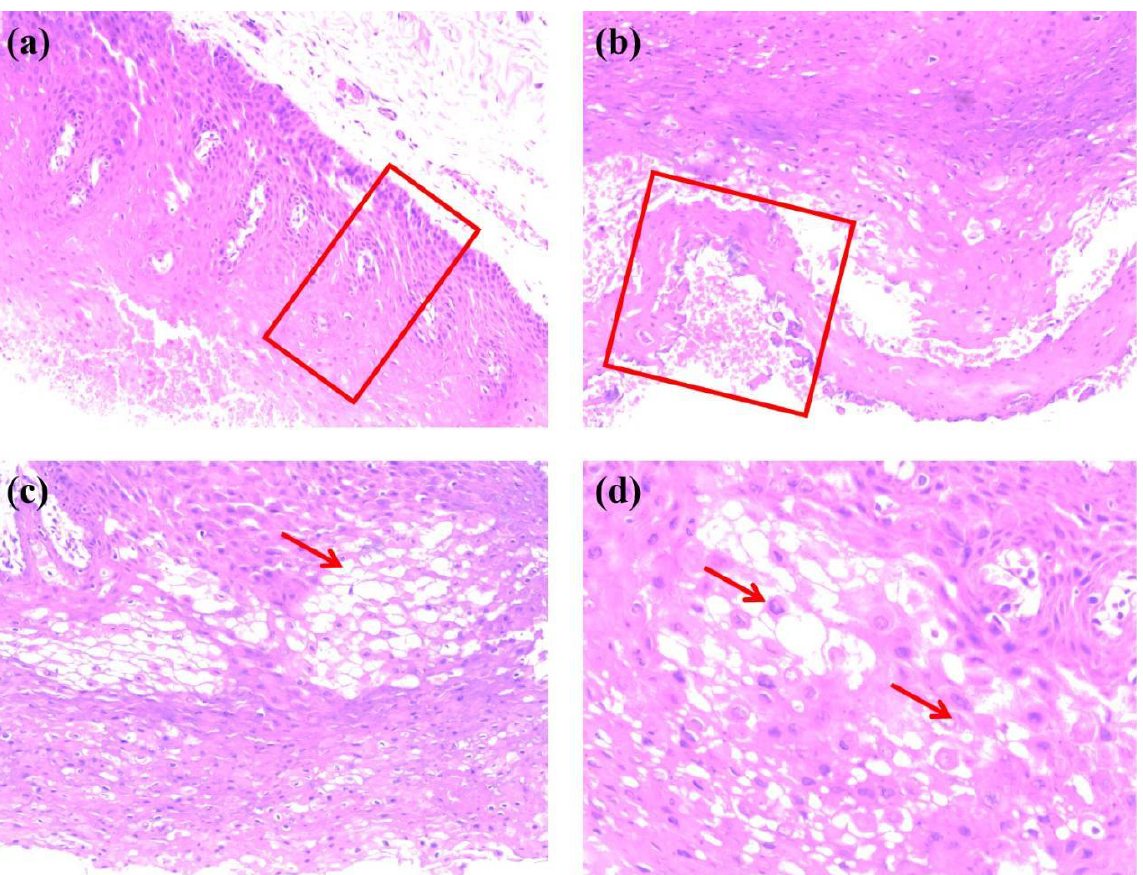
Figure 6. Hematoxylin-eosin staining of the right buccal mucosa of the proband’s father with ( a ) the red frame indicating enlarged spinous cells and well differentiated basal cells with increased number of layers (40×), ( b ) the red frame indicating incomplete keratinization of surface cells and uneven epithelial tissue with no inflammatory infiltration (100×), ( c ) the red arrow indicating vacuolar change of spinous cells (200×), and ( d ) the top and bottom arrows indicating spinous cells with nuclear pyknosis and cell edema, respectively (400×).